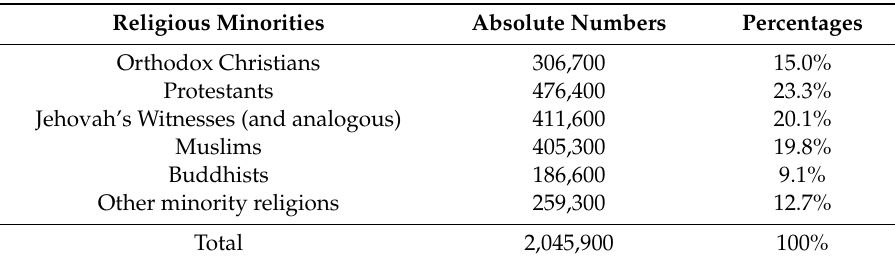
Table 1. Religious minorities among Italian citizens.